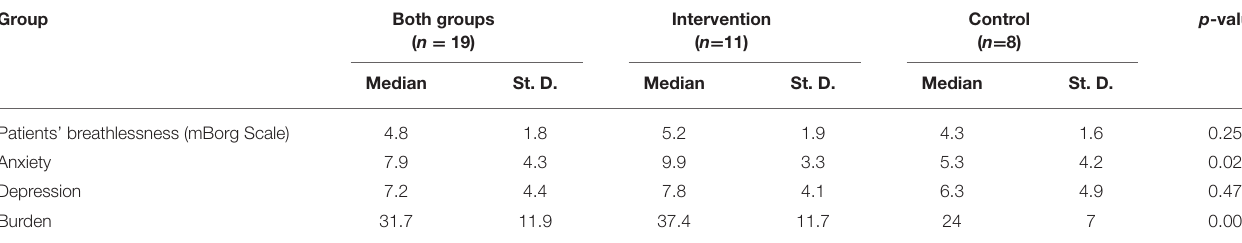
TABLE 4 | Family caregivers baseline assessments’ median intervention and control group. Group